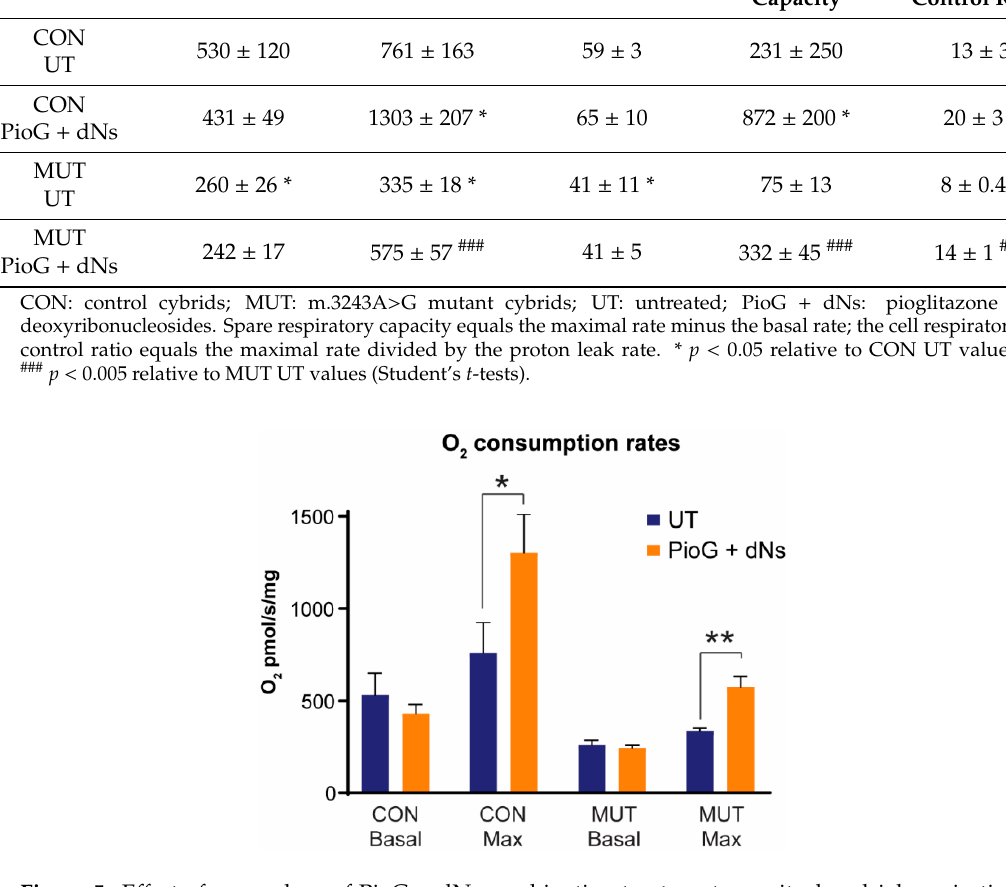
Figure 5. E ff ect of seven days of PioG + dNs combination treatment on mitochondrial respiration in control (CON) cybrids and m.3243A > G (MUT) cybrids. Basal and maximal respiration rates in untreated MUT cybrids were 49% and 44% of respective untreated CON cybrid rates. PioG + dNs treatment did not a ff ect basal respiration rates in either cell type, but increased maximal respiration rates by 71% in both CON and MUT cybrids. UT = untreated. Values shown are mean ± s.d. * p < 0.05, ** p < 0.01. Statistical calculations are comparing treated cybrids to their respective untreated controls (Student’s t